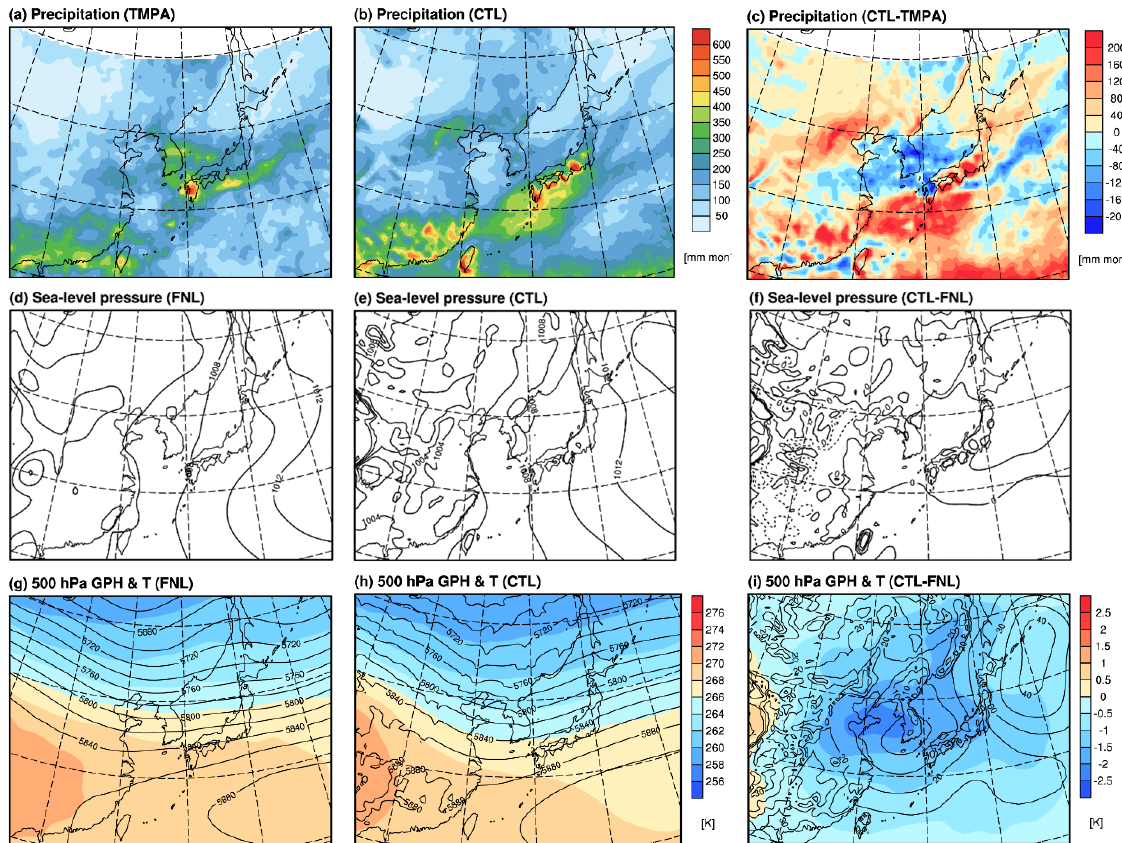
Figure 1. Spatial distribution of precipitation (mm month − 1 ; top) over East Asia averaged for June–July–August (JJA) 2006 from the ( a ) Tropical Rainfall Measuring Mission (TRMM) Multi-satellite Precipitation Analysis (TMPA) observation and ( b ) CTL experiment, and sea-level pressure (hPa; middle) and 500 hPa geopotential height (gpm; solid line) and temperature (K; shading) (bottom) from the ( d , g ) FNL data and ( e , h ) CTL experiment. ( c , f , and i ) The differences between the CTL experiment and observations are shown in the right column. Contour interval is 1 hPa in ( f ), with negative contours dashed.